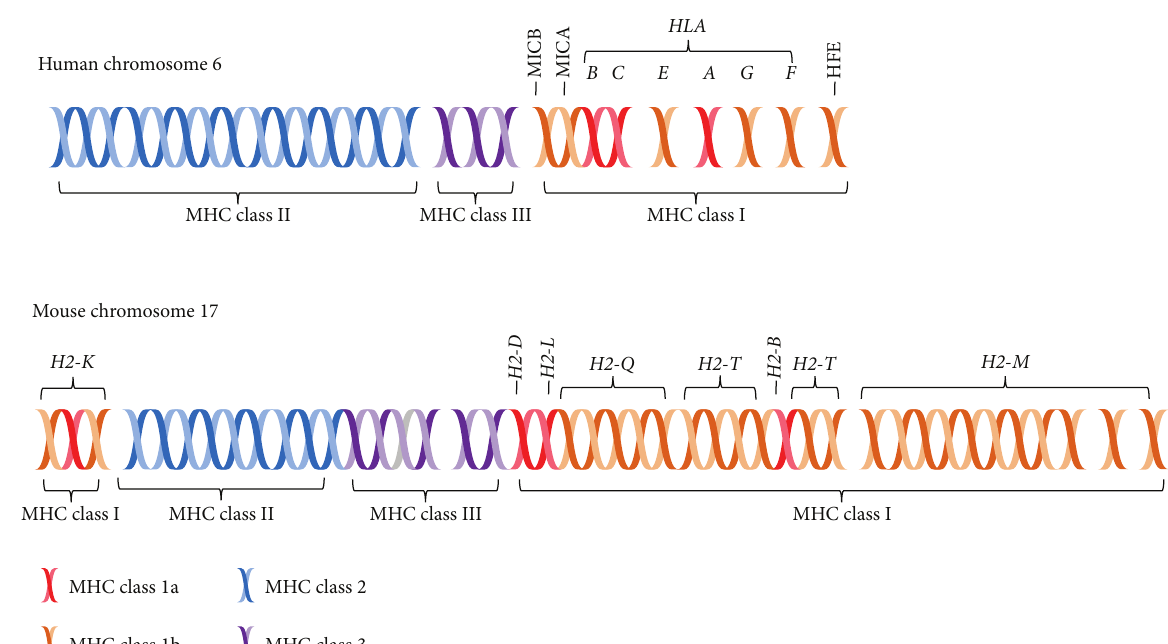
Figure 3: Comparison of MHC regions on chromosome 6 in humans and chromosome 17 in mice. The classical MHC class Ia genes (red), which include HLA-A , HLA-B , and HLA-C in humans and H2-K , H2-D , H2-L , and H2-B in mice, are much more polymorphic than the nonclassical, MHC class Ib genes (orange). H2-L is closely related to H2-D and is only found in BALB/c mice. MHC class III proteins are not involved in antigen presentation. This figure was adapted from Elmer and McAllister